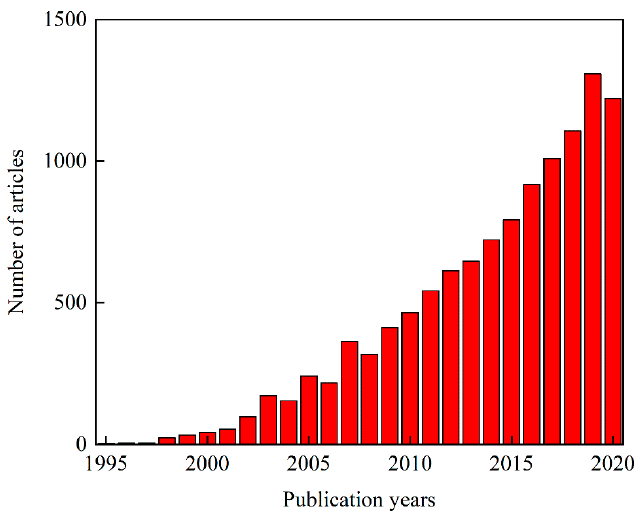
Figure 1. Number of articles per year related to spark plasma sintering (SPS) technology (source: Web of Science).